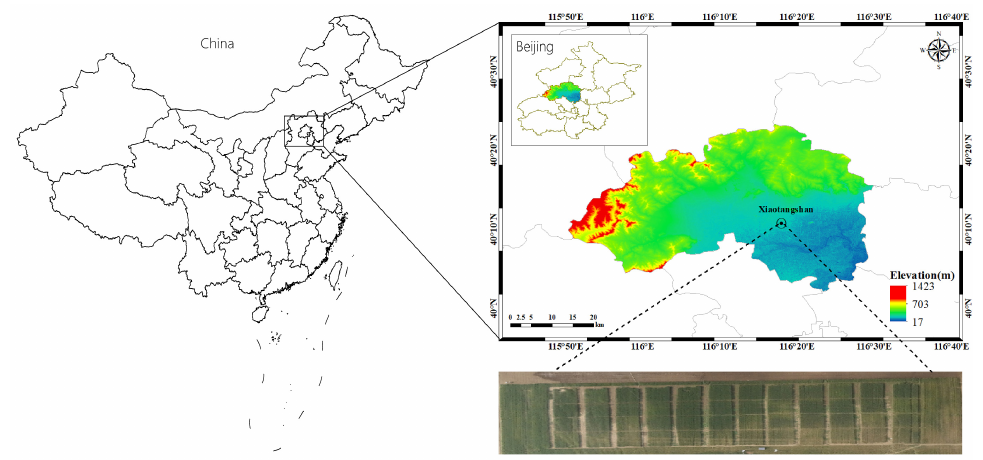
Figure 1. Schematic diagram of the study area and experimental design.